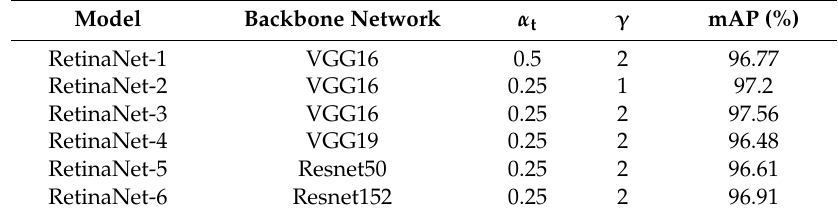
Table 2. Six configurations of RetinaNet and their corresponding ship detection mean average precision (mAP).